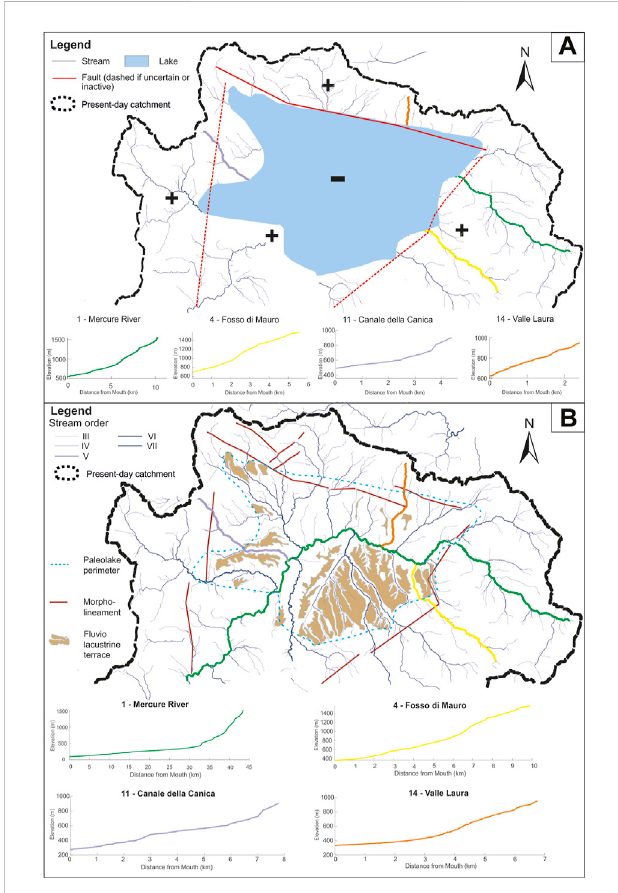
FIGURE 11 Sketch showing the drainage network evolution of the study area (see text for further explanation). (A) Schematic reconstruction of the drainage network pattern and longitudinal pro fi les prior to the drainage integration; (B) present-day